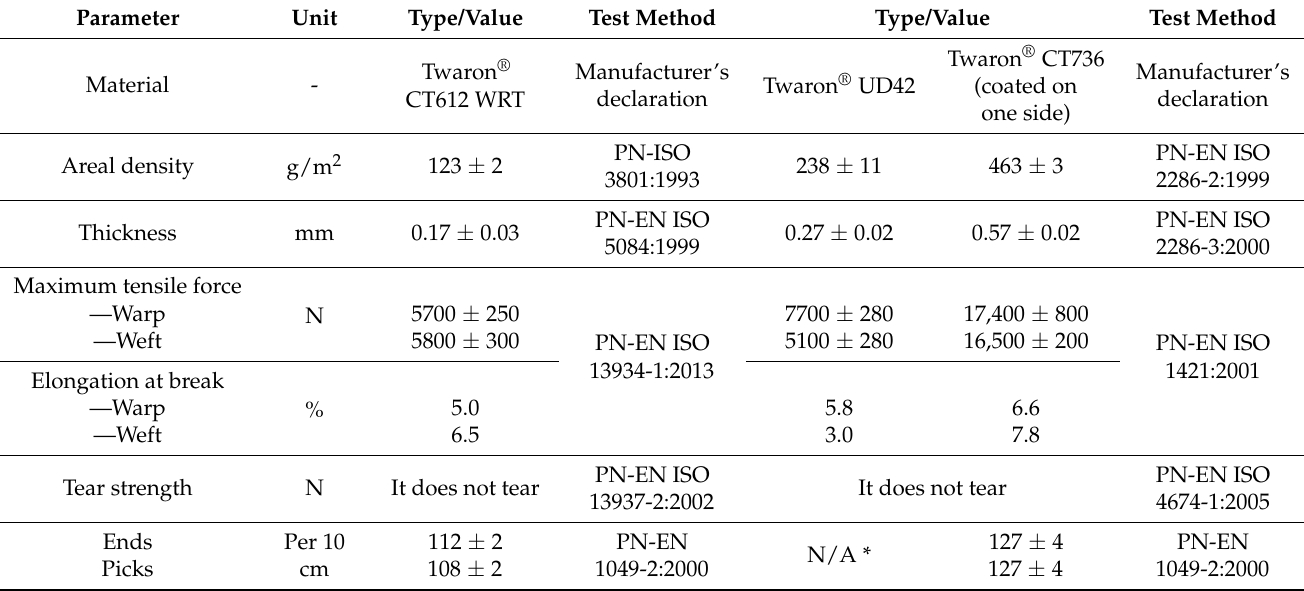
Table 1. PhysicomechanicalpropertiesofTwaron ® para-aramids(TeijinAramidGmbH,Wuppertal,Germany).